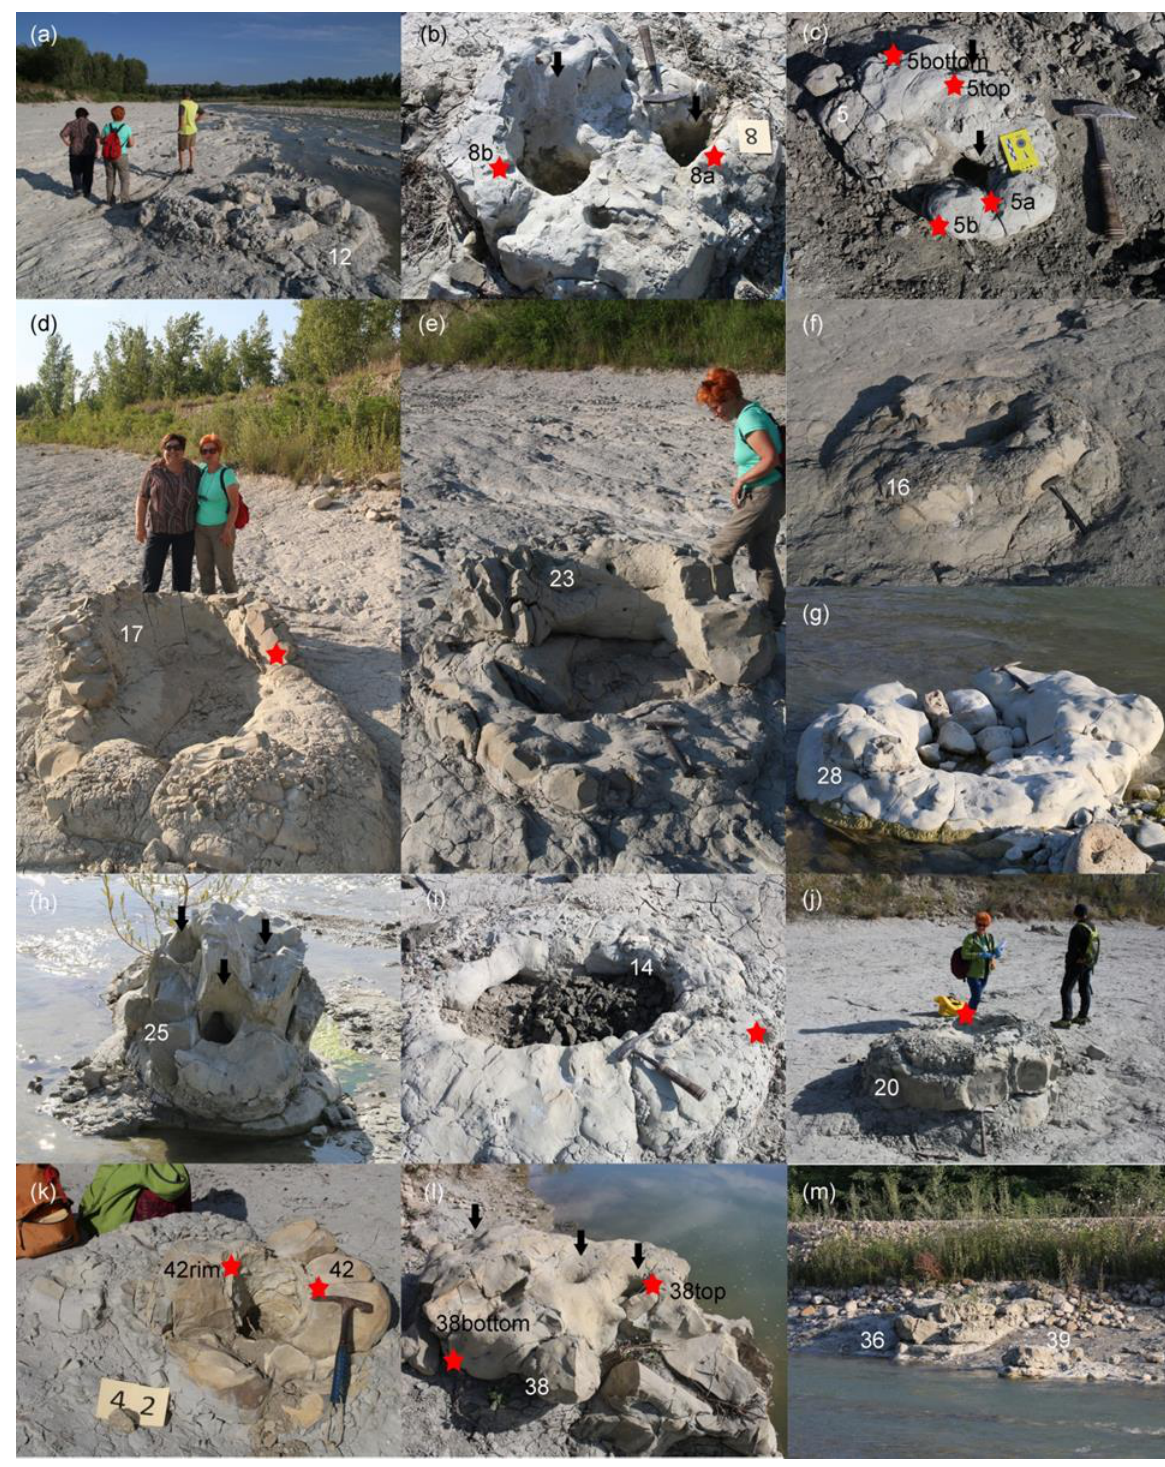
Figure 4. Carbonate conduit concretion morphologies. ( a , e , j , m ) Stacked doughnuts; ( b , c , h ) Tronco- conical shape: note that all possess double open mouths; ( d , f , g , i , k ) Ring doughnuts; ( l ) Stratiform concretion with small open mouths. Black arrows indicate the open mouths. Sizes and positions are given in Table 1. The white numbers refer to the list in Table 1, and the red stars indicate the sample positions.